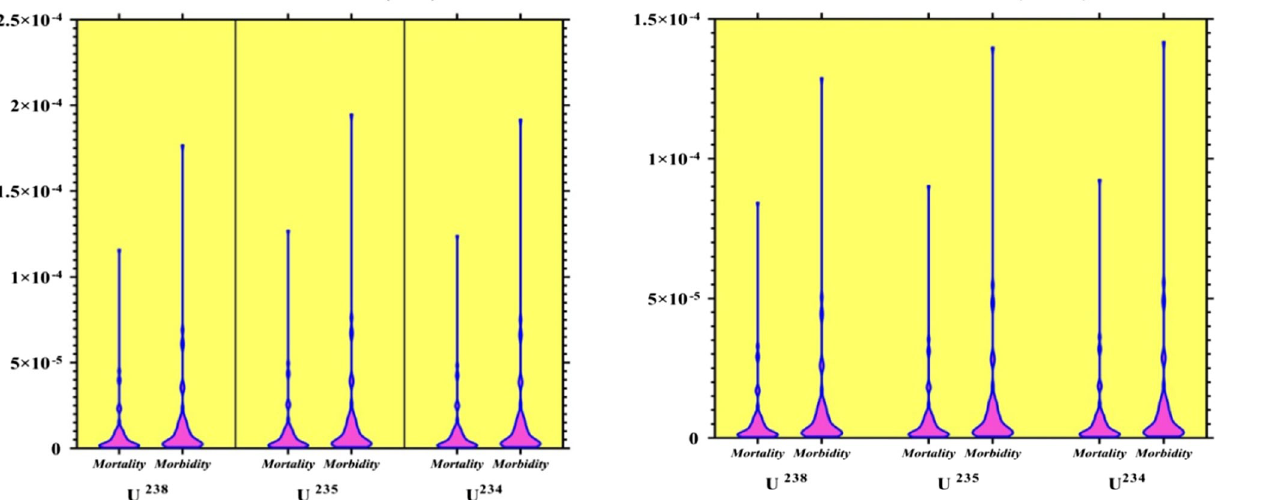
Fig. 26 Distribution of life time cancer risk (males) in the samples